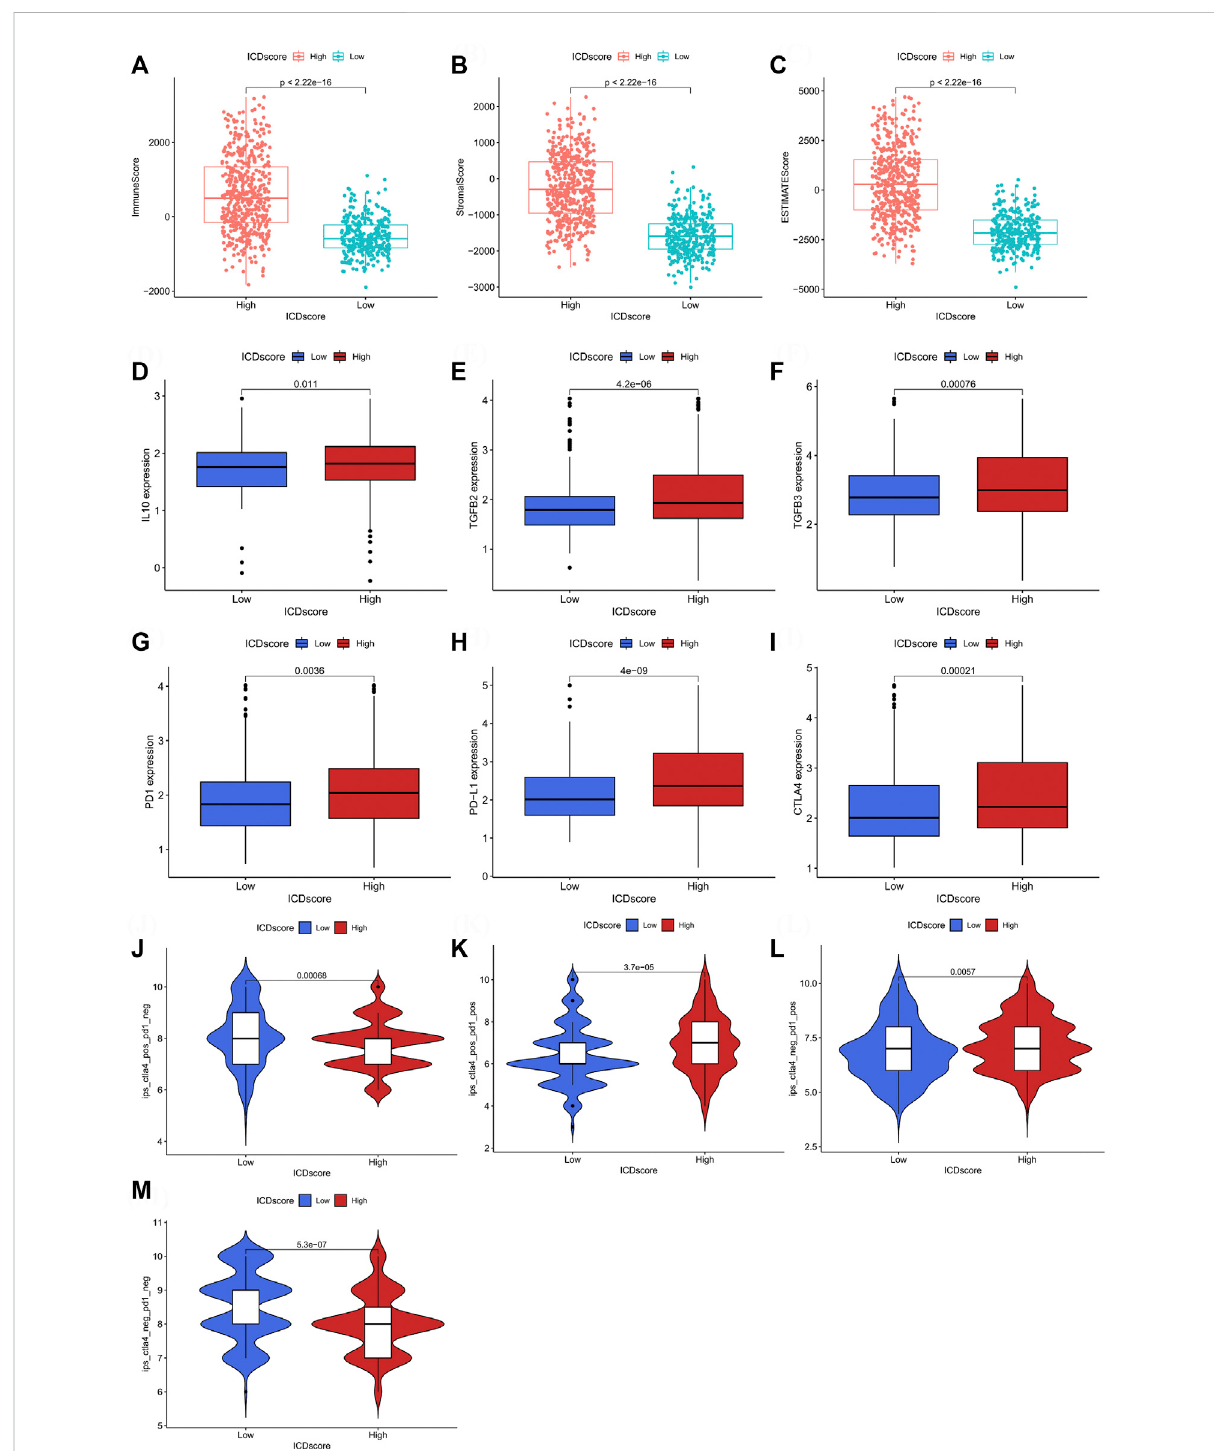
FIGURE 8 The indication of ICD score on immune microenvironment and prediction of immunotherapy response in bladder cancer. (A – C) ESTIMATE immune score between different ICD score groups. (D – F) Differences in the expression of IL10, TGF β 2 and TGF β 3 between different ICD score groups. (G – I) Differences in the expression of PD-1, PD-L1 and CTLA-4 between different ICD score groups. (J – M) Differences in the immunotherapeutic effects of four different strategies between the different ICD score